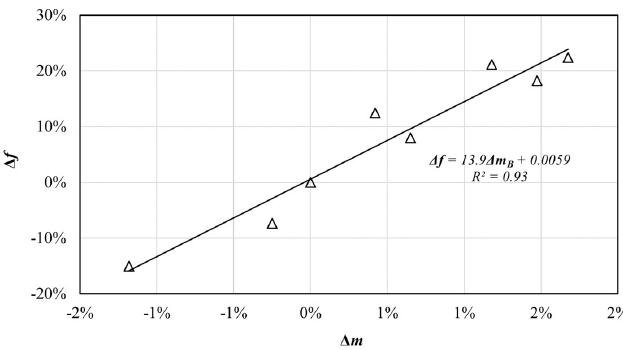
Figure 13. The relationship between Δ f and Δ m B of structural EPS concrete.